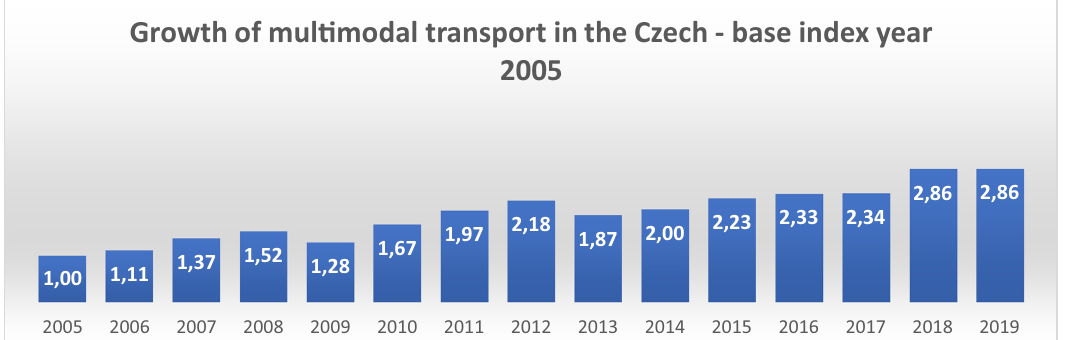
Figure 1: Base index of combined transport growth ( in tkm ) – ( % ) . Source: own